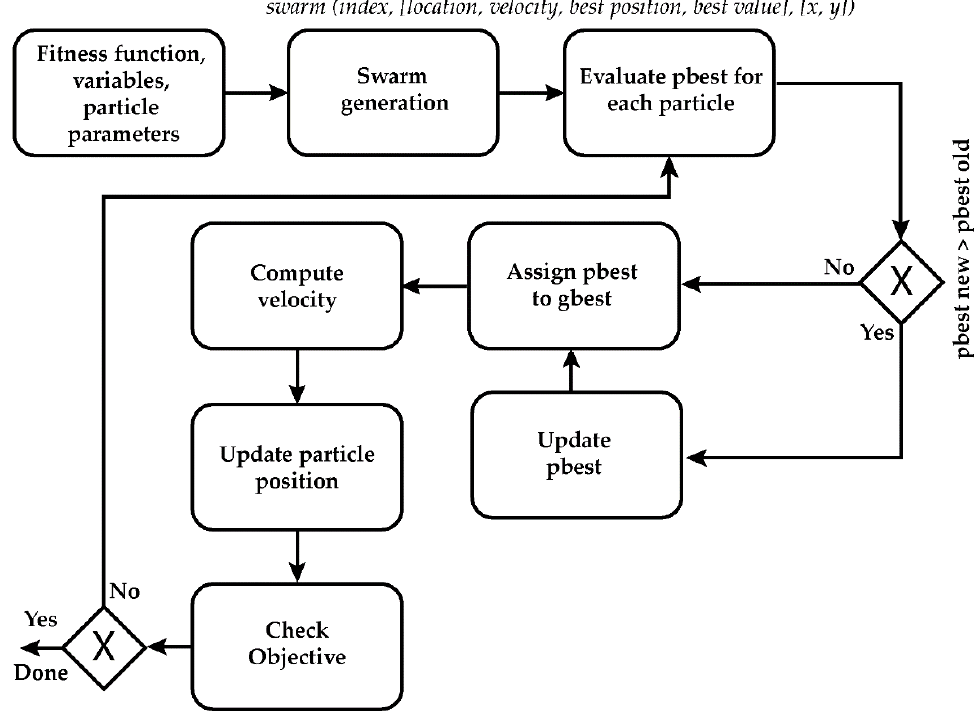
Figure 6. General PSO process diagram.